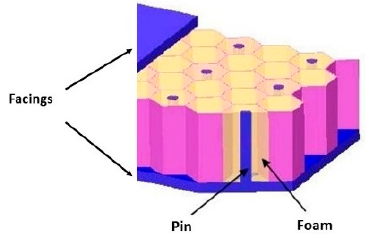
Figure 14. Schematic representation of PU foam-filled honeycomb core composite panel. Adapted from [57].